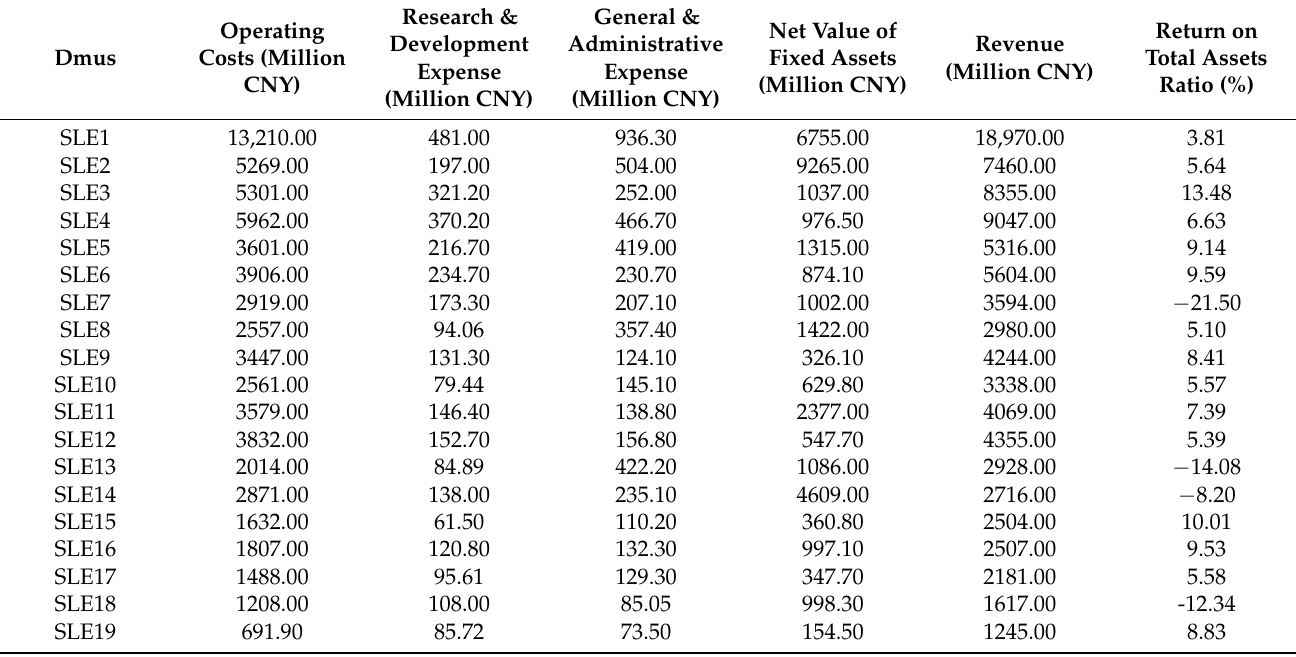
Table A3. Input and output variables for 34 listed LED energy enterprises in